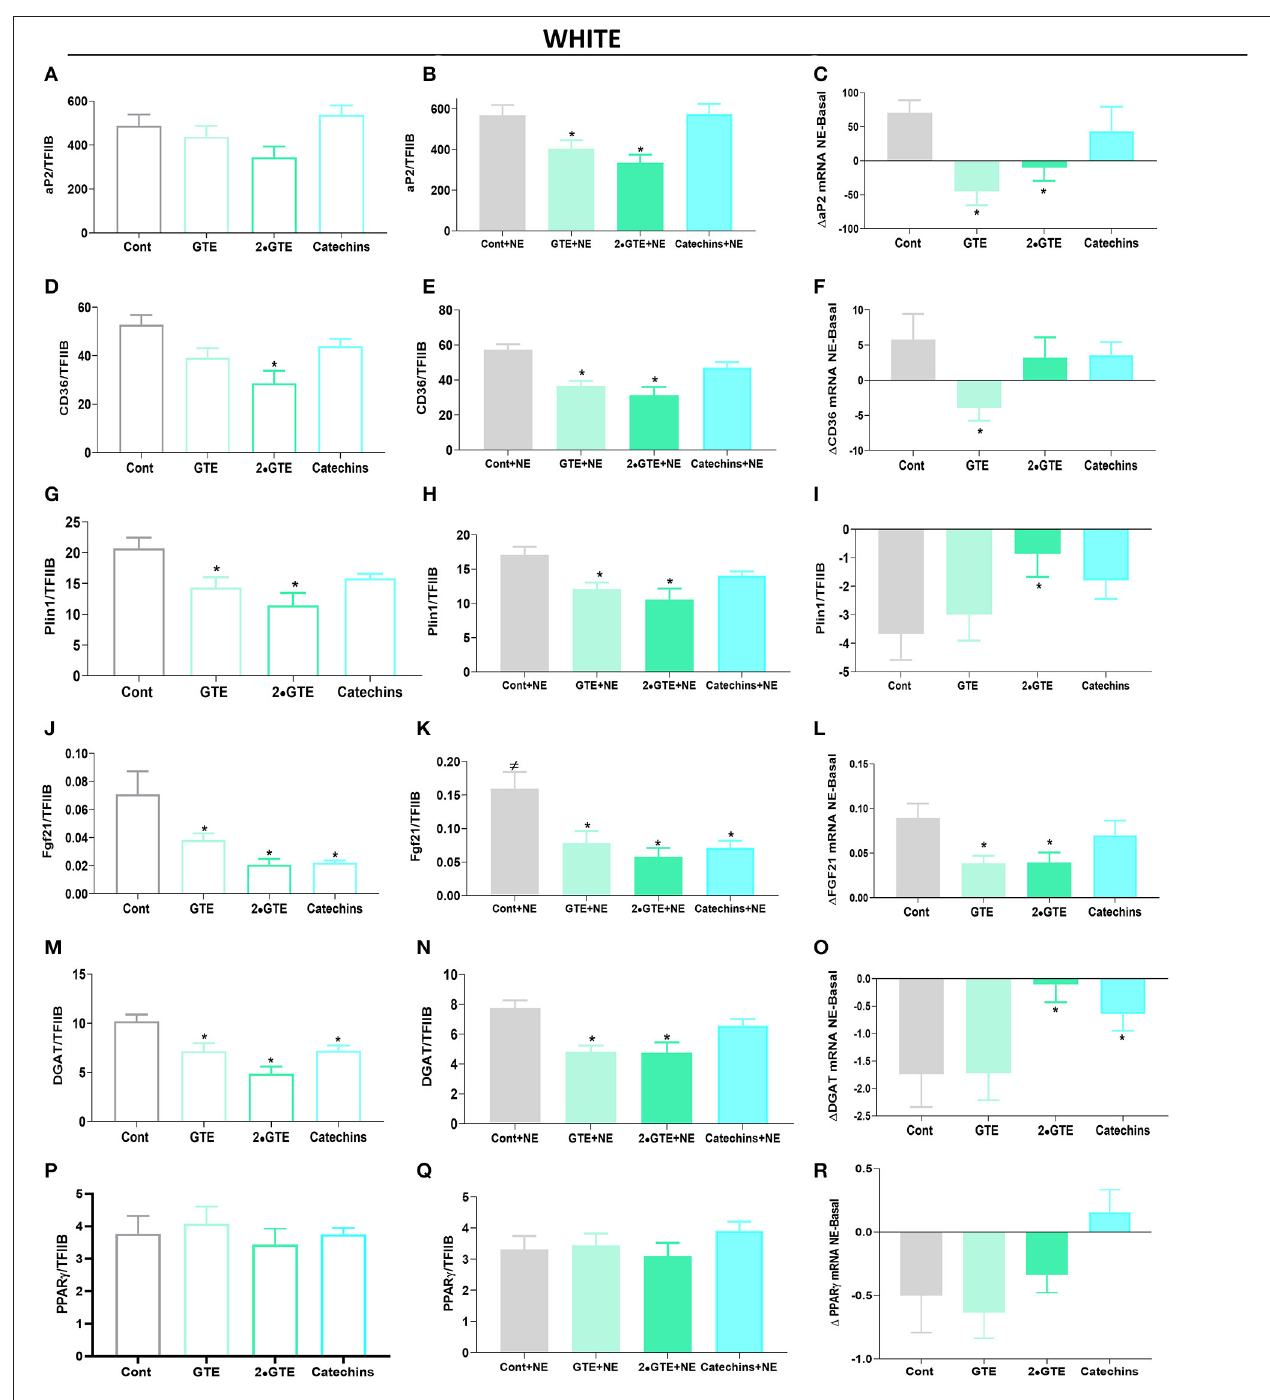
FIGURE 4 | Effect of green tea compounds on expression of genes associated with lipid metabolism in white adipocytes. The white adipocytes in Figures 1 , 2 were further analyzed for the expression levels of genes associated with lipid metabolism. aP2 mRNA levels in basal (A) and NE-stimulated states (B) and the norepinephrine-induced change (C) . (D–F) results for CD36; (G–I) results for Plin1; (J–L) results for Fgf21; (M–O) results for DGAT; (P–R) results for PPAR γ . The results are means ± SEM of five independent experiments, each performed in duplicate. Statistics are as in Figure 1 .